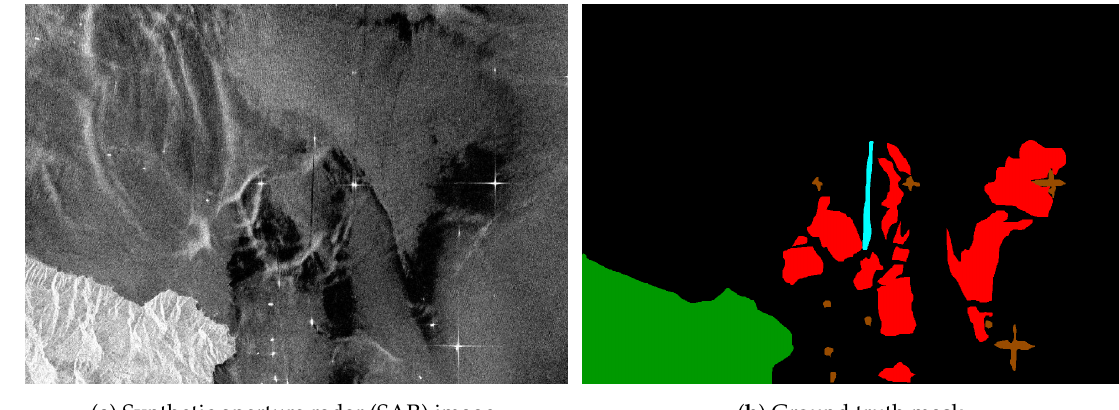
Figure 1. ( a ) Sample of a SAR image and ( b ) Corresponding annotated image. Cyan color corresponds to oil spills, red to look-alikes, brown to ships, green to land and black is for sea surface.